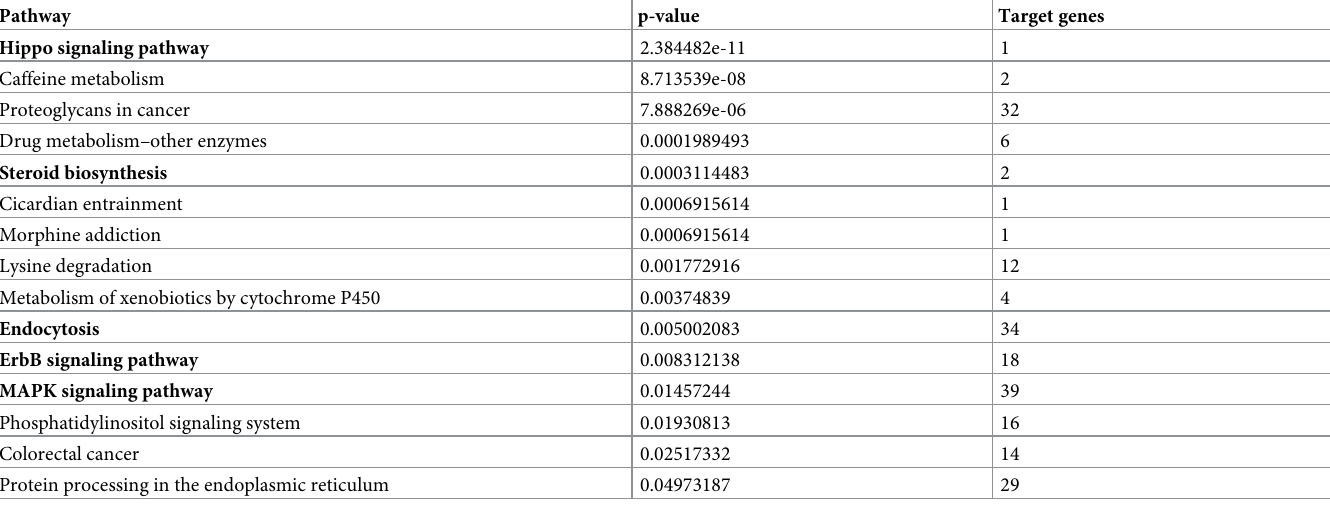
improving the course of the healing process [31, 32]. The miR-34 family also seems to be Table 5. Statistically significant union pathways refer to the miRNAs with a decreased expression on day 5.